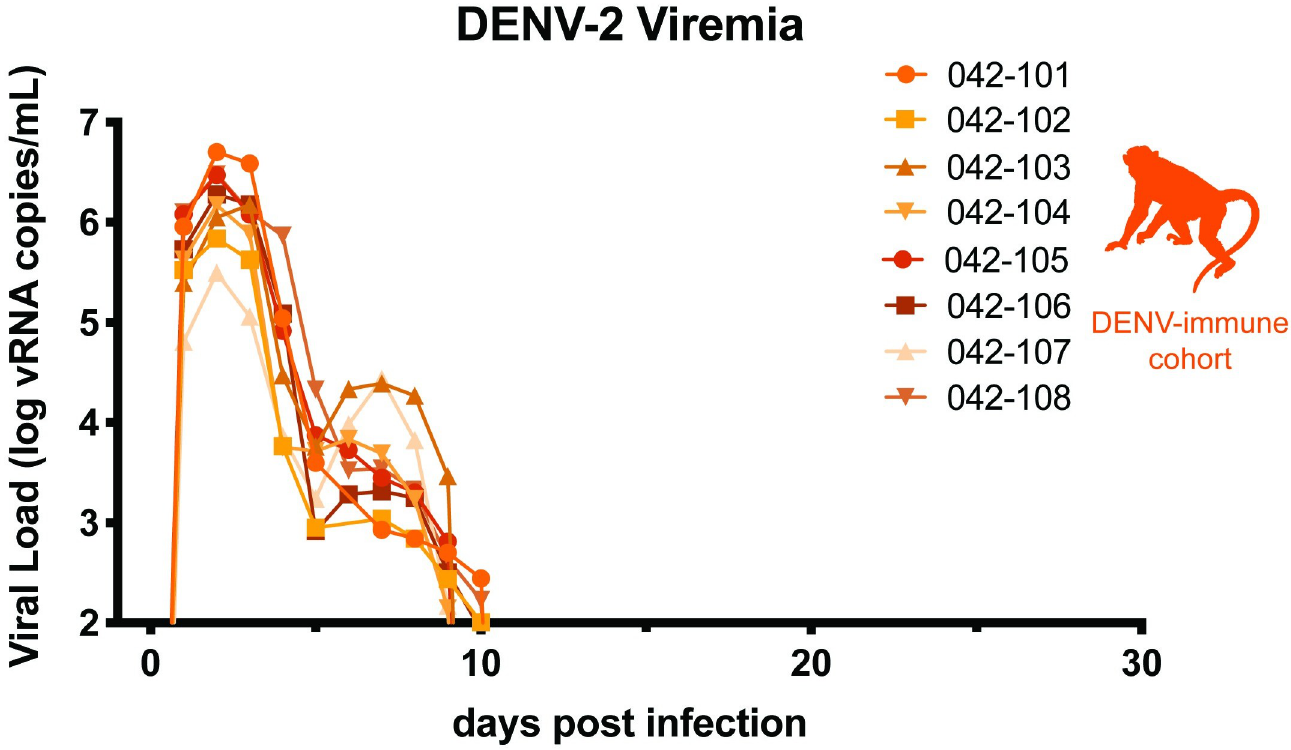
Fig 2. Replication of DENV-2. Eight non-pregnant macaques were inoculated with 10 4 PFU DENV-2/US/BID-V594/2006, a 2006 human isolate from Puerto Rico. QRT-PCR was performed on plasma samples from 0–10, 14, 21, and 28 days post-infection (d.p.i). All values above the limit of quantification for the QRT-PCR assay (100 copies vRNA/mL plasma) are